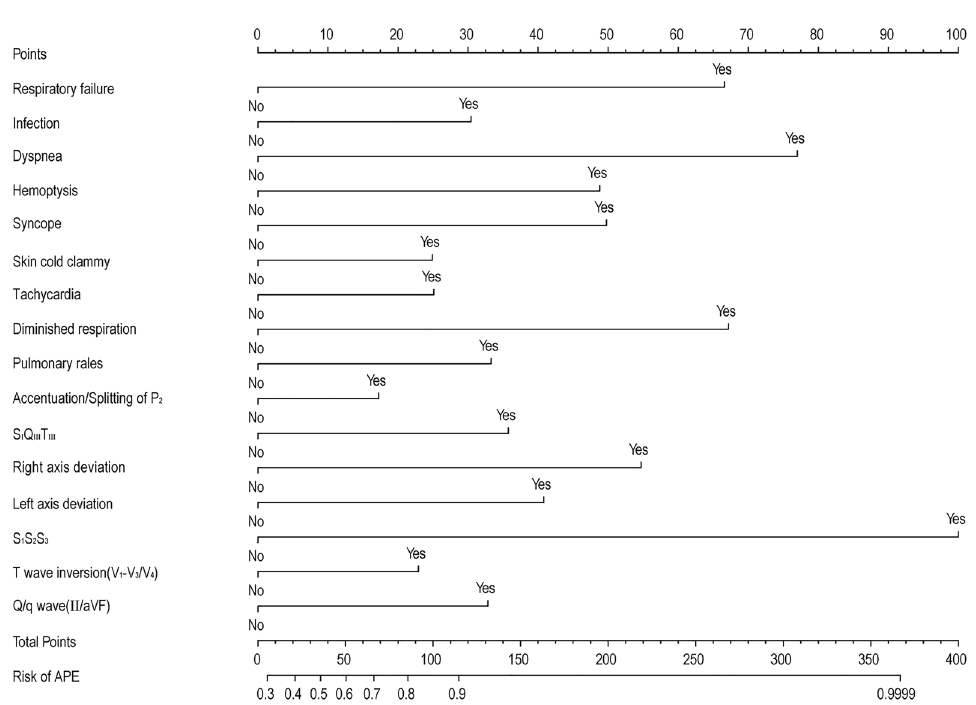
Figure 5. Nomogram to estimate the probability of acute pulmonary embolism. The figures were created using R software